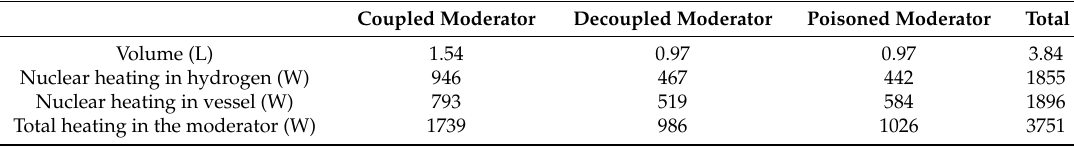
Table 3. Estimated nuclear heating power deposited on each moderator at 1 MW proton